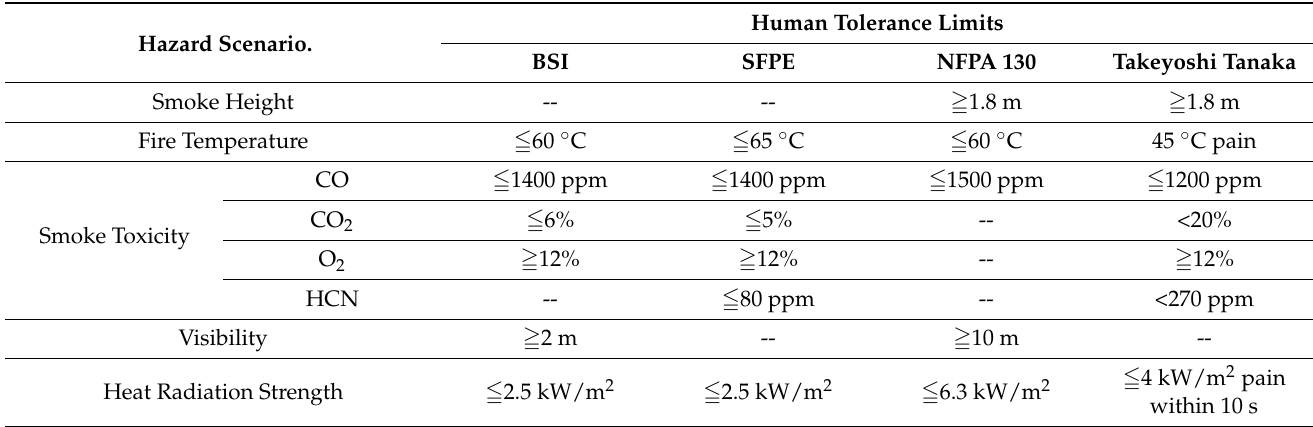
Table 3. Fire hazard indicators for human tolerance (organized in this study).